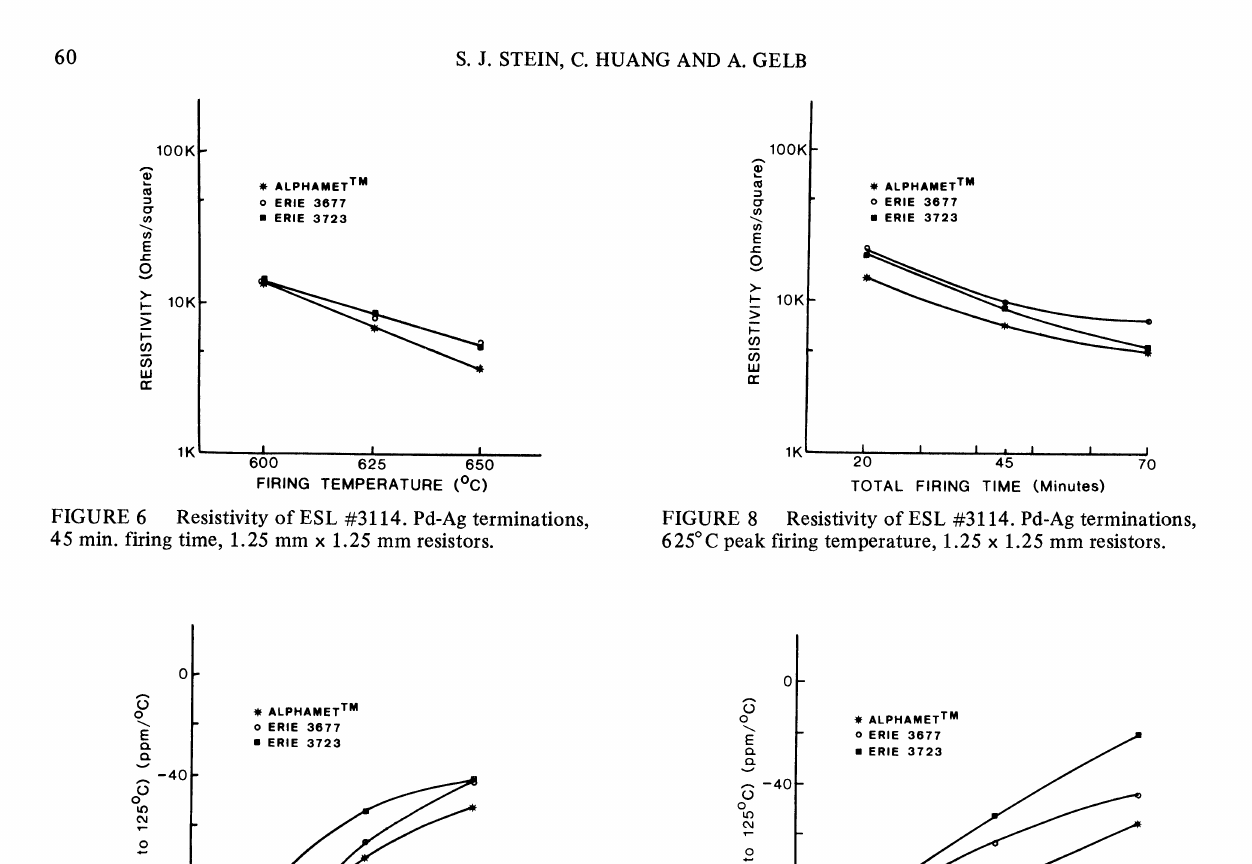
FIGURE 7 TCR of ESL #3114. Pd-Ag terminations, 45 min. f’tring time, 1.25 mm x 1.25 mm resistors.